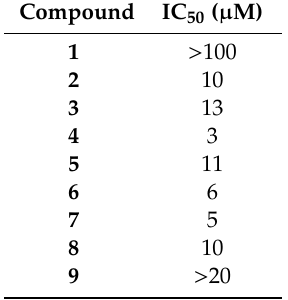
Table 1 summarized the IC 50 values obtained for each compound. With exception of compounds 1 and 9 , all components revealed a strong cytotoxic activity, with IC 50 below 15 µ M. The most e ff ective compounds were 4 , 6, and 7 (IC 50 of 3, 6, and 5 µ M, respectively). Table 1. Cytotoxic e ff ect of compounds 1 – 9 in THP-1 cells reported as IC 50 in µ M. Cells metabolic activity was determined after 24 h of incubation with or without compounds at di ff erent concentrations (2, 5, 10 and 20 µ M for compounds 2 – 9 and 10, 25, 50 and 100 µ M for compound 1 ) by resazurin assay (n = 3). Doxorubicine was used as a positive control at 1 µ M for our experiments. At 1 µ M, the viability of THP-1 decreased at around 80% (21.4 ± 3% of the fluorescence after 24 h of incubation, with negative control normalized as 100%). Compound IC 50 ( µ